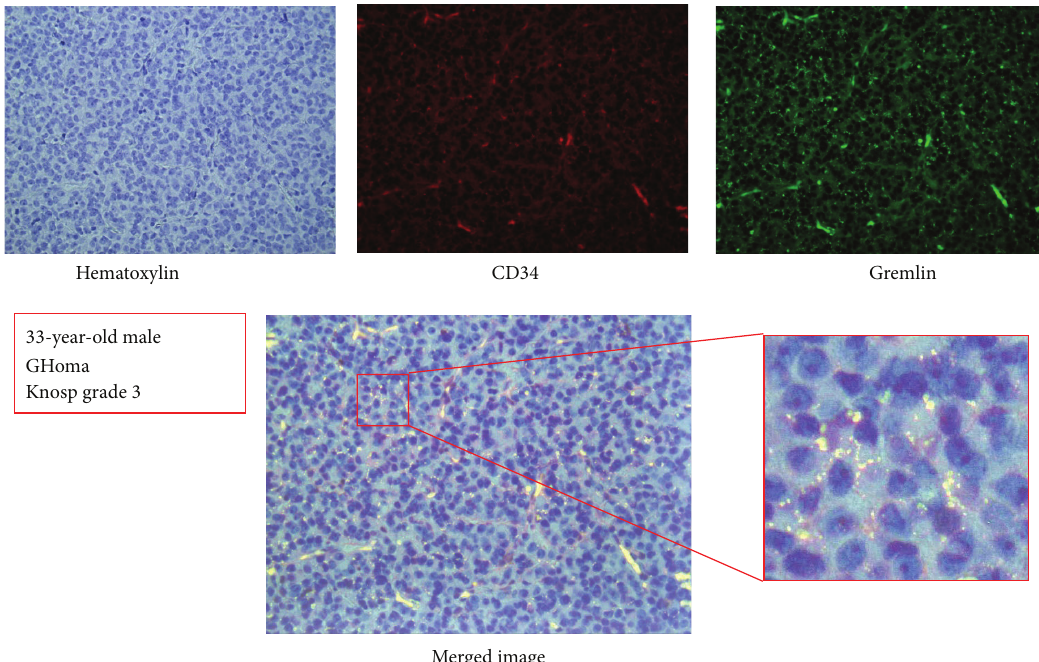
Figure 1: Merged double immunofluorescence image. Expression of Gremlin and CD34 in pituitary adenoma tissue in a representative case of a 33-year-old male with GHoma, Knosp grade 3; 40x magnification. Yellowish fluorescence indicates colocalization of Gremlin and CD34 in cytoplasma of tumor parenchymal cells (Gremlin, FITC; CD34,